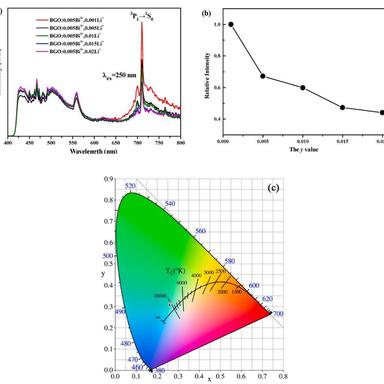
(a) PL spectra of BGO: 0.005Bi3+, yLi+ (y = 0.001–0.02), (b) relative intensity at 710 nm and (c) CIE chromaticity diagram for BGO: 0.005Bi3+, yLi+ (y = 0.001–0.02) samples.